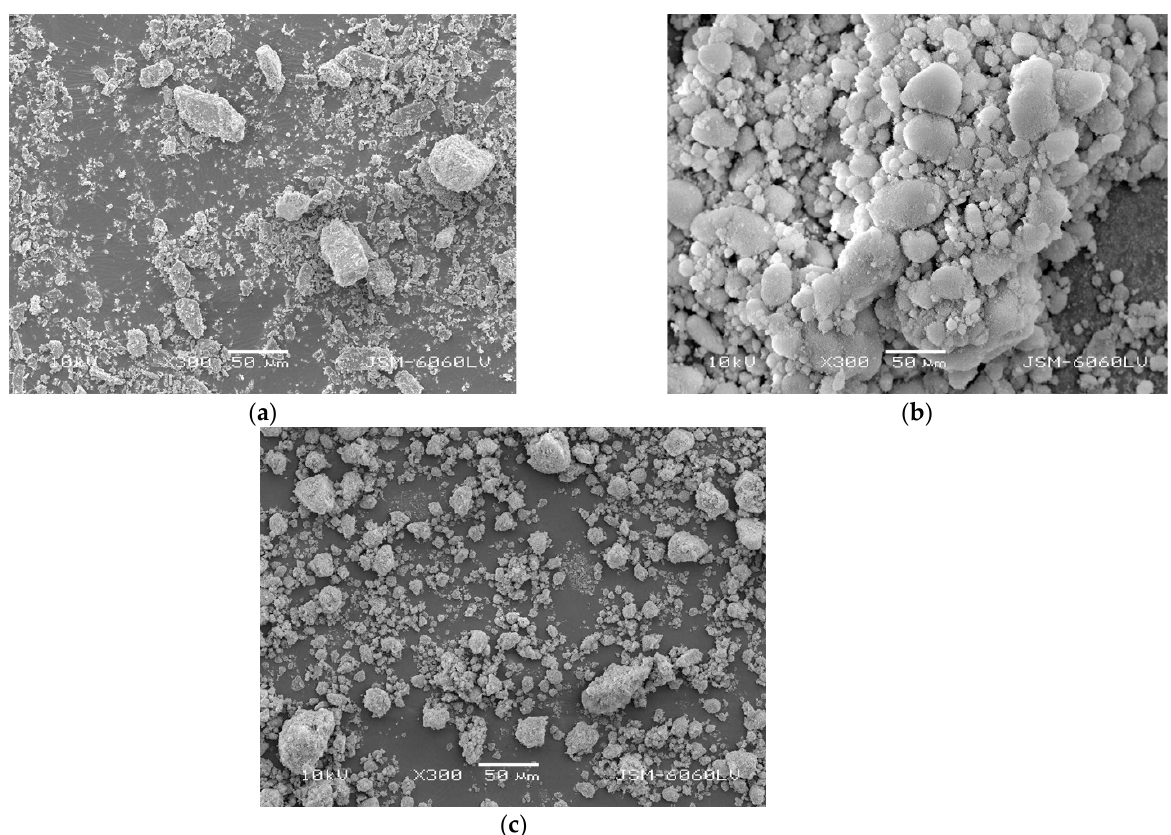
Figure 3. ( a ) UV visible (daylight invisible) fluorescent red pigment as received (mag. 300×); ( b ) silicon dioxide (fumed silica) as received (mag. 300×.); ( c ) titanium (IV) oxide as received (mag. 300×).